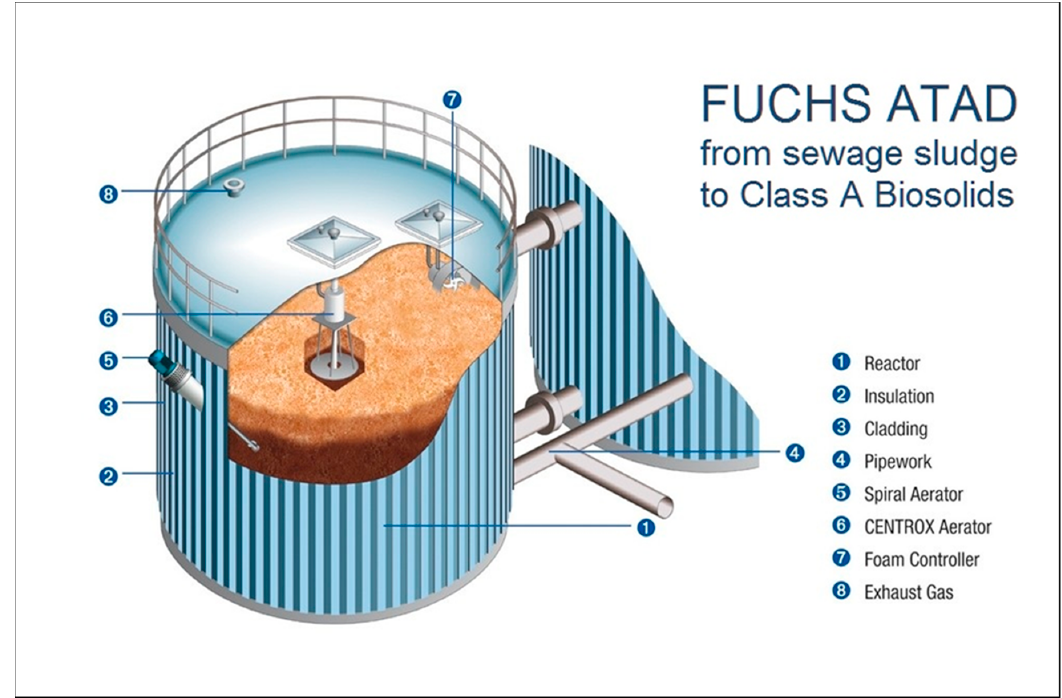
Figure 2. Operation of the autothermal thermophilic aerobic digestion (ATAD) reactor [21].